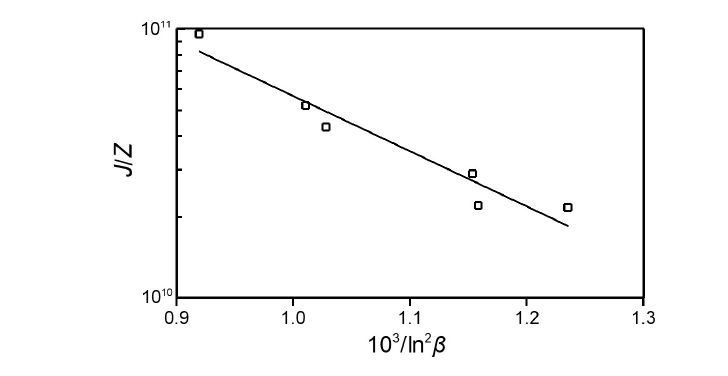
Figure 3. Plot of nucleation rate according to Equation